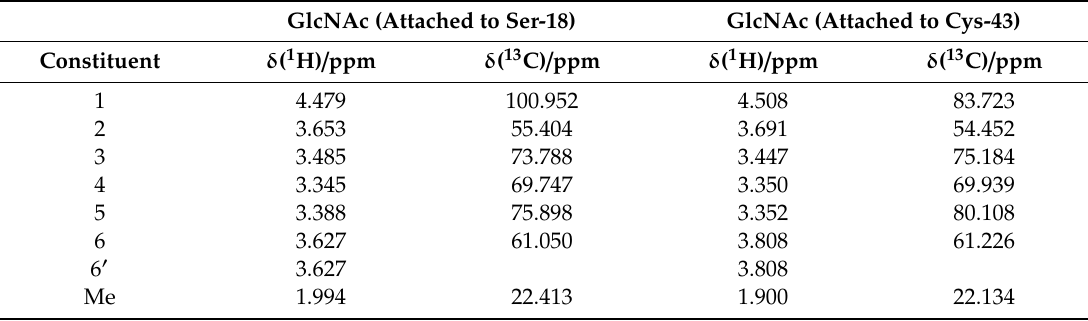
Table 1. Chemical shift data of the post-translational modifications of ASM1. GlcNAc (Attached to